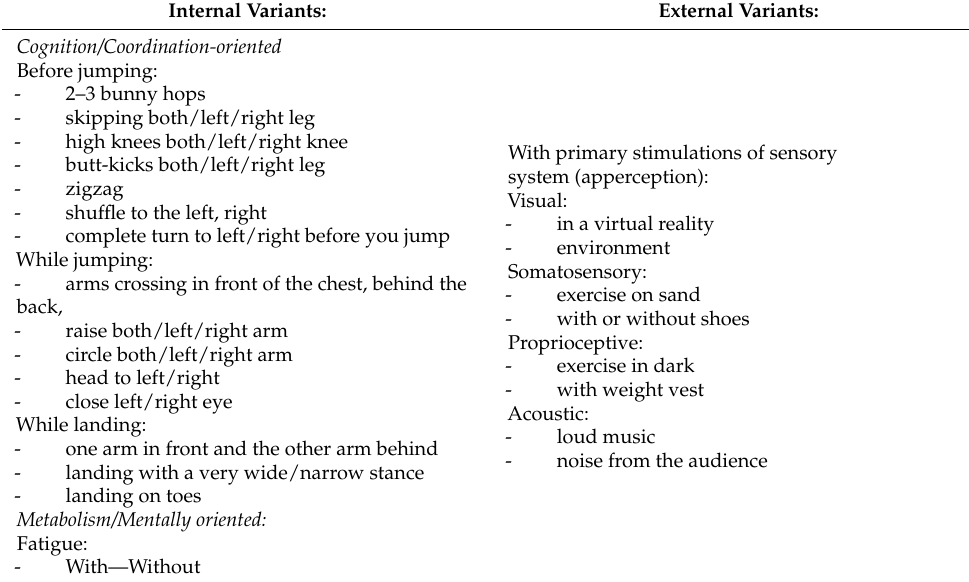
Table 2. Differential training exercises [13].